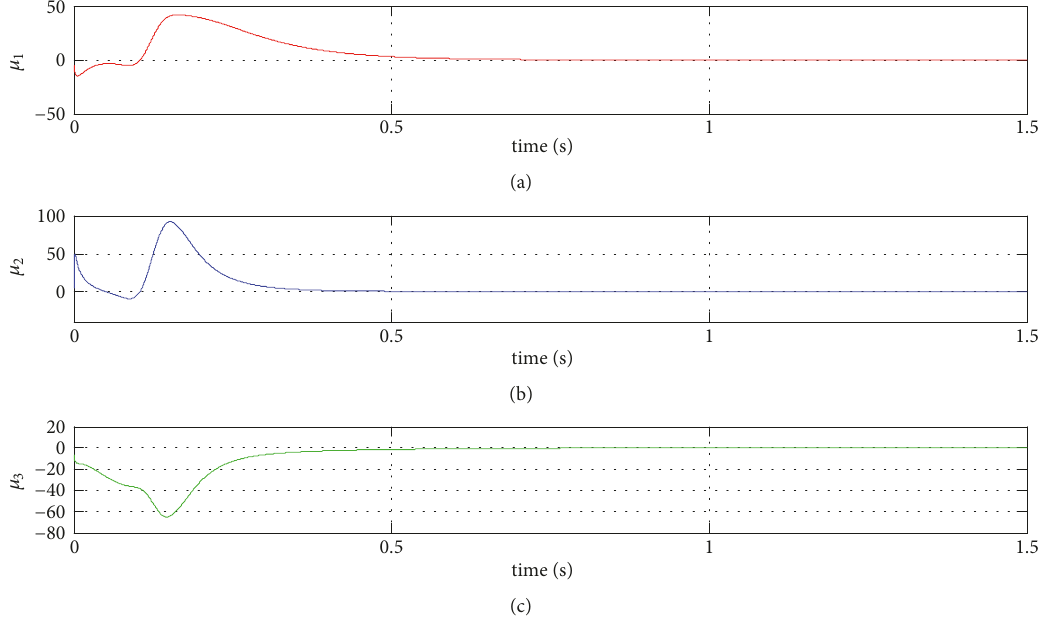
Figure 4: Control law: (a) 𝜇 1 , (b) 𝜇 2 , and (c) 𝜇 3 .